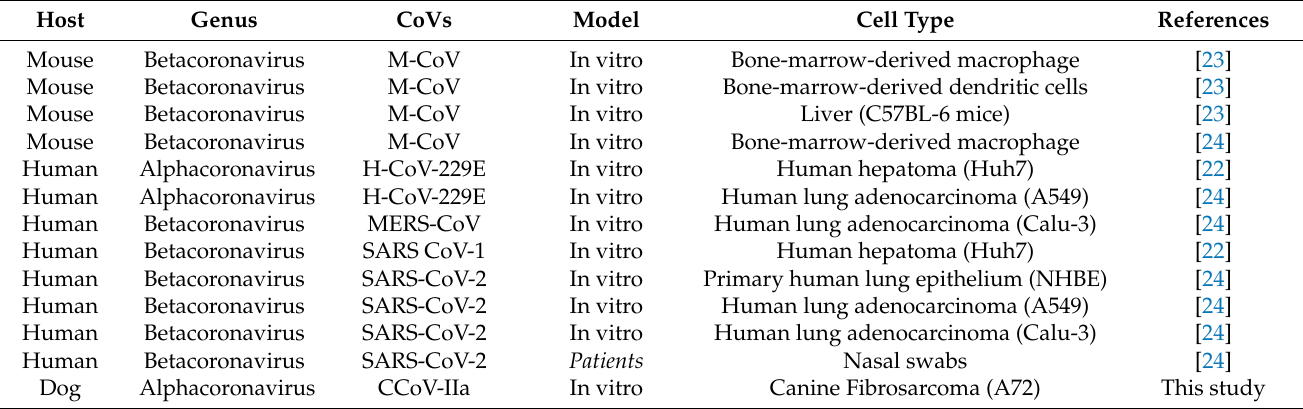
Table 1. Summary of studies describing AhR up-regulation following infection with some Alpha- coronaviruses and Betacoronaviruses.